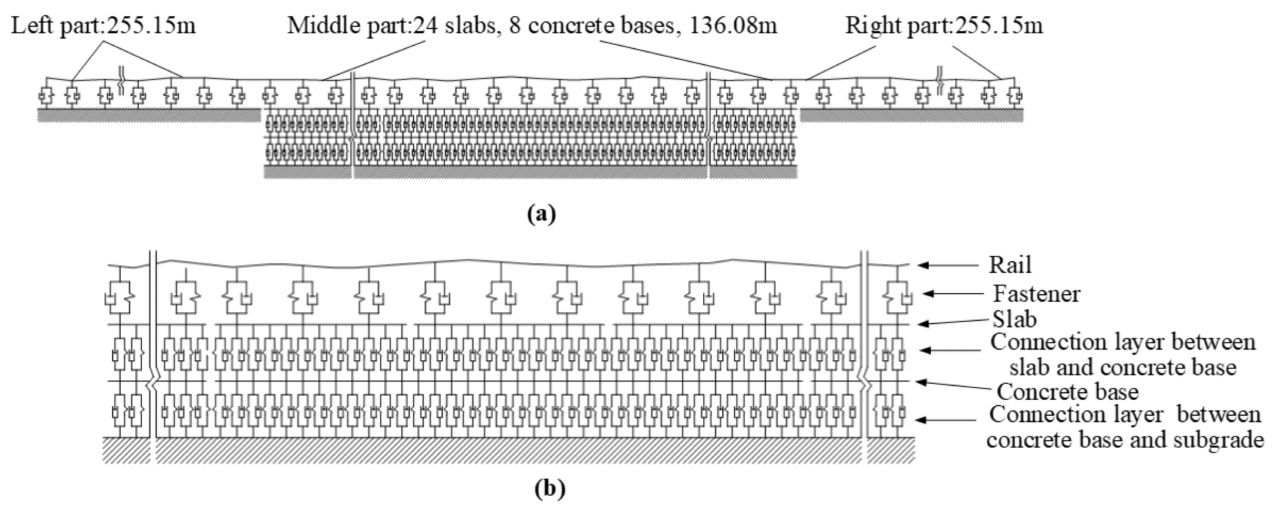
Figure 2. Schematic of CRTS III slab track–subgrade sub-model: ( a ) overview and ( b ) partial view. In the sub-model, the length of the left and right parts are 255.15 m and the length of the middle part is 136.08 m. The length of each slab is 5.67 m, the length of each concrete base is 17.01 m, and 24 slabs and 8 concrete bases are modeled in the middle part.